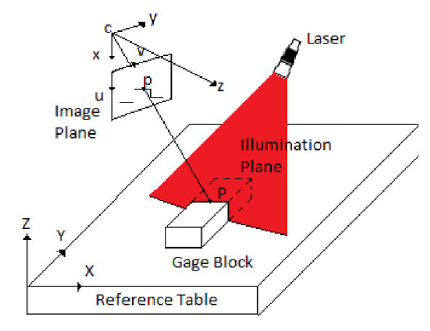
Figure 3. Illumination plane for 3D reconstruction with active